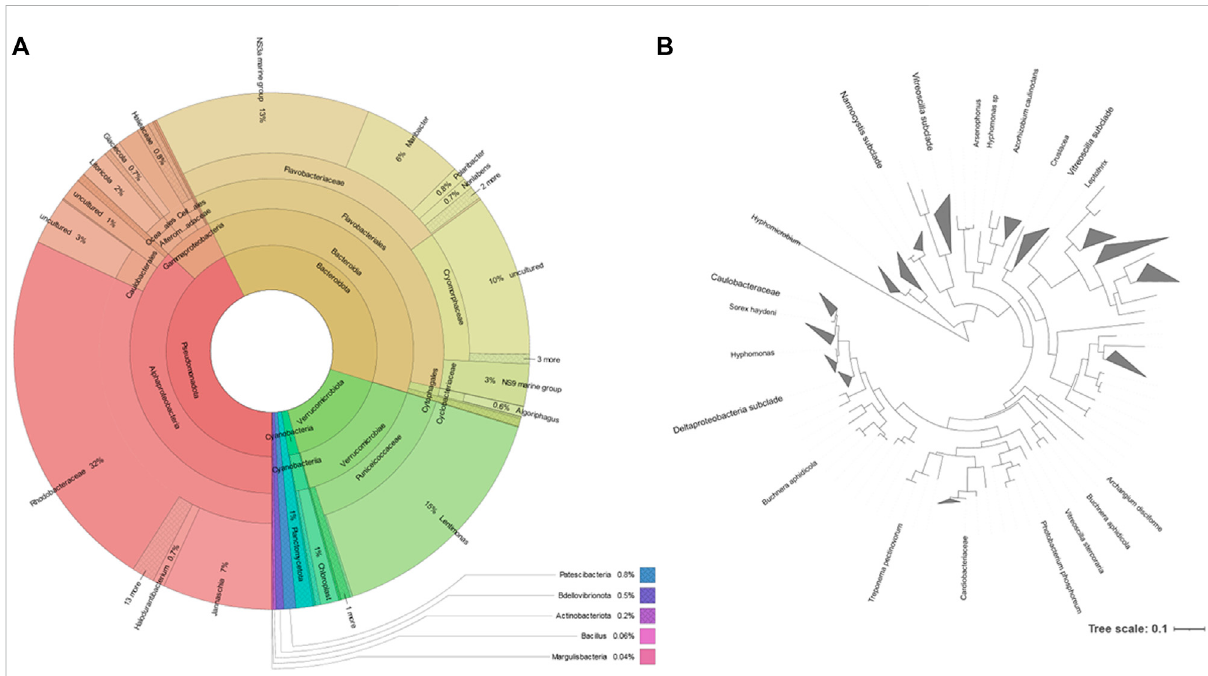
FIGURE 4 Taxonomic distribution of the microbial community of the rock pond according to the metataxonomic data. (A) : Krona chart, which should be read from the inside to the outside (Ondov et al., 2011). Colors indicate the taxonomic group to which the OUT was assigned and each ring of the chart represents a different taxonomic level. (B) : phylogenetic tree of the reads belonging to the Pseudomonadota phylum generated by the Interactive Tree of Life (iTOL) (Letunic and Bork, 2021); only bootstrap values > 0.6 are